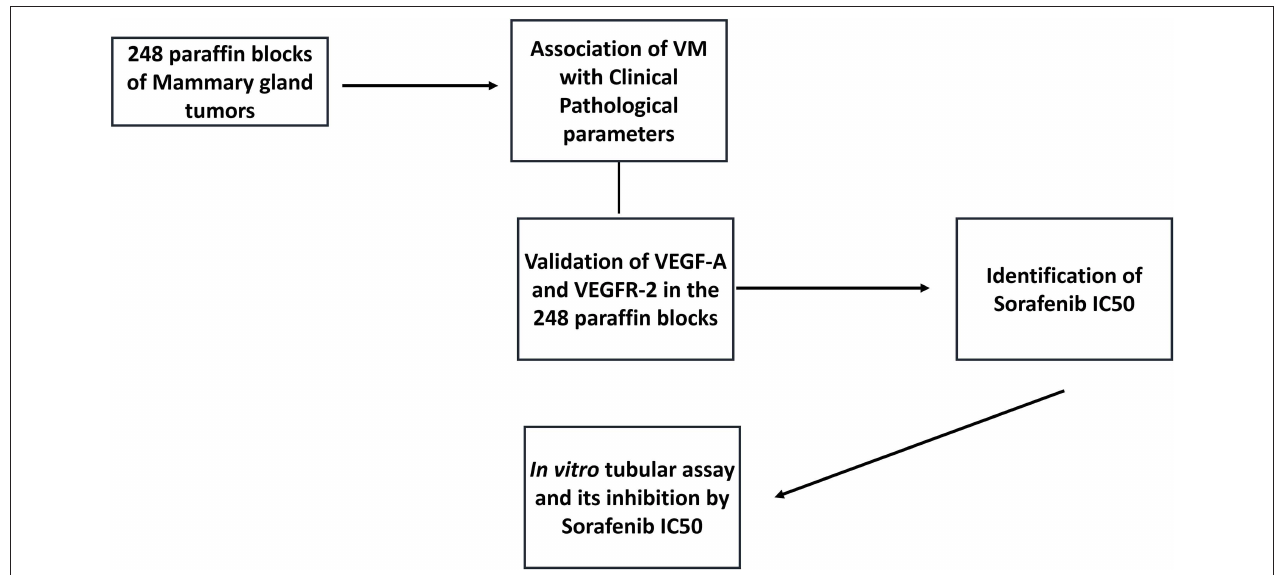
FIGURE 1 | Graphic representation of the study design. We selected 248 mammary gland tumors from the veterinary pathology service, and samples were evaluated for the presence of vasculogenic mimicry (VM). Then, we performed CD31/PAS double staining to identify VM structures, confirming that samples were positive for VM. Two canine mammary gland tumor cell lines were selected, and an in vitro tubular assay was performed to identify the cellular VM ability. Based on the VEGF-A and VEGFR-2 immunohistochemical analysis, we selected VEGF-A/VEGFR-2 and validated their expression in our tumor group. After confirming the associations of VEGF-A/VEGFR-2 expression with VM, we performed in vitro assays to evaluate the ability of sorafenib (a VEGFR-2 inhibitor) to inhibit VM in vitro